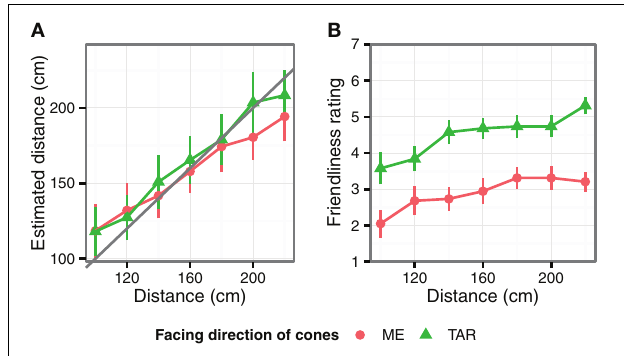
FIGURE 4 | The results of Experiment 3. (A) The average estimated distances as a function of viewing distance and cone direction. (B) The average rating scores. The error bars indicate standard error of the